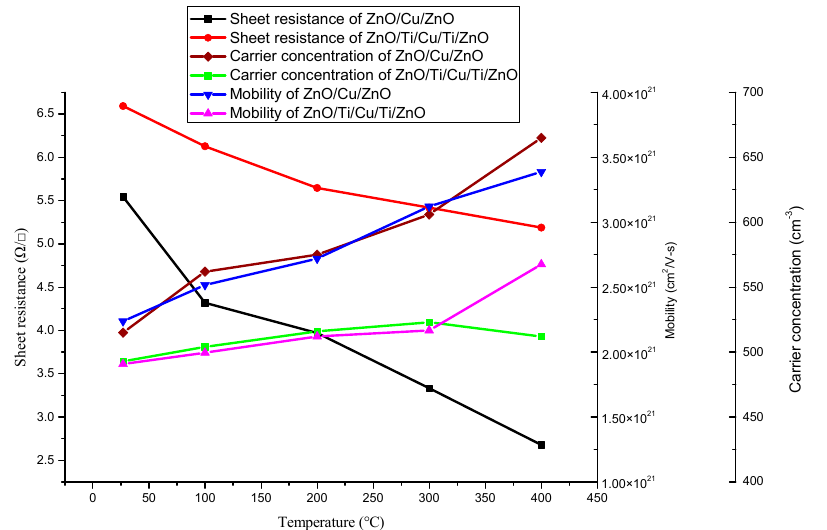
Figure 4. Electrical properties of two ZnO transparent conductive thin films with varying annealing temperatures.